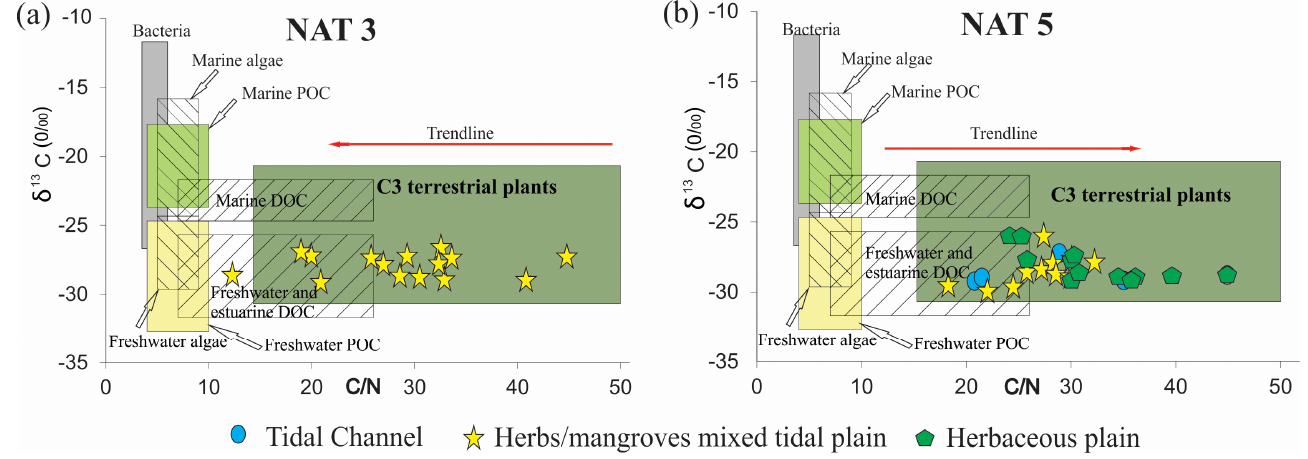
Figure 8. Diagram with the relationship between δ 13 C and C:N for the NAT − 3 and NAT − 5 cores according to the interpretations and data presented by [48,49] for the different sources of organic matter.